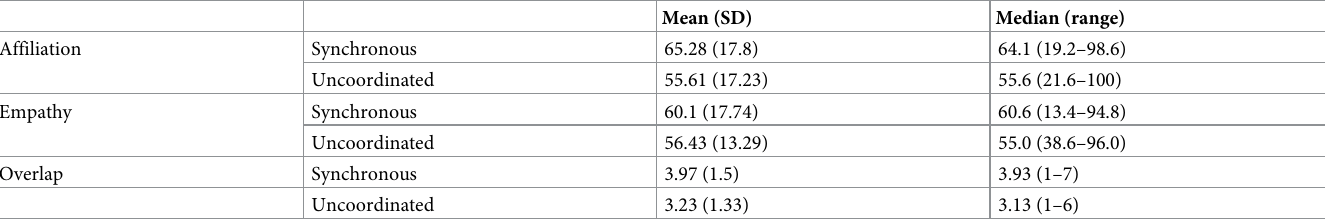
Table 6. Descriptive statistics for the total affiliation, empathy and overlap ratings towards the confederate in Study 2.